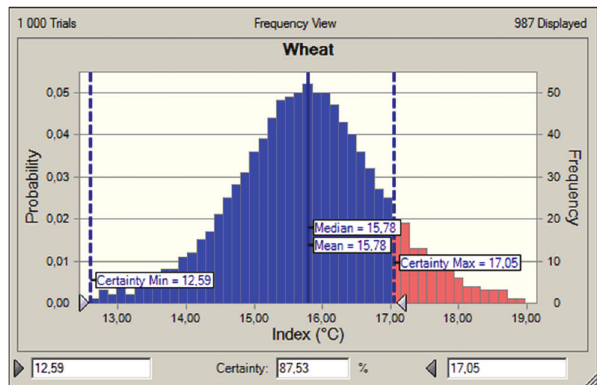
Figure 1: Risk layering with farmers’ participation of 10% (strike 1) for wheat.